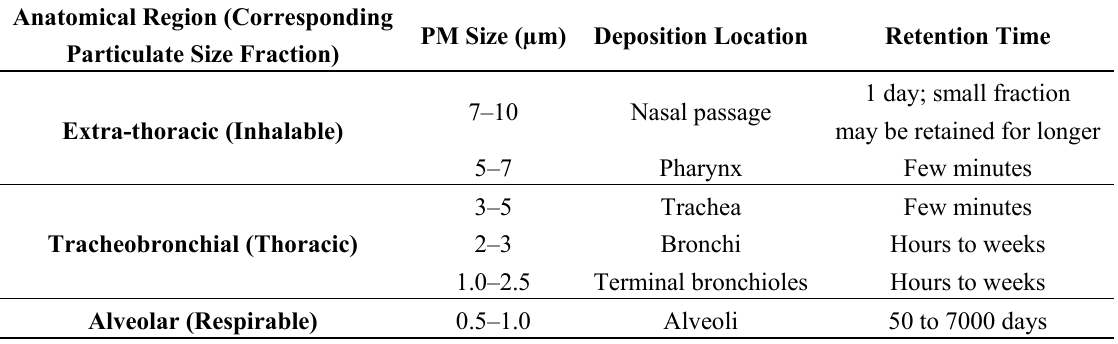
Table 2. Deposition of PM in different regions of the human respiratory tract [115,116] 10 as a function of particle size (data from Newman [72]), including the estimated retention time of the particle size in each deposition location (data from Bailey